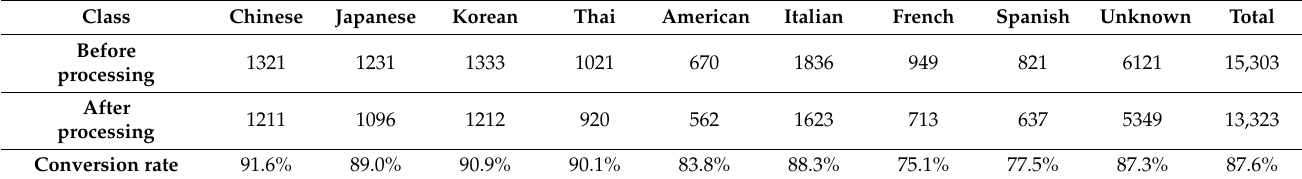
Table 1. Number and conversion rate of recipes in each category before and after preprocessing.